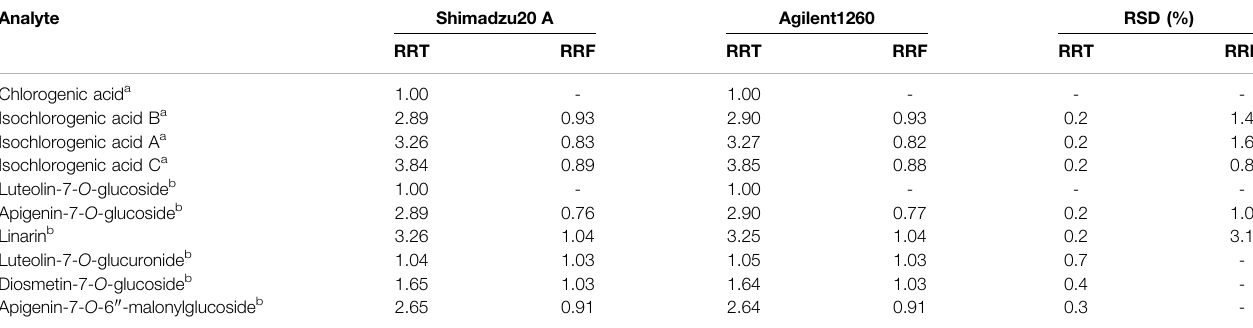
TABLE 3 | Ruggedness of the RRT and RRF of marker components in C. morifolium/C. indicum fl ower, n (cid:2) 7.